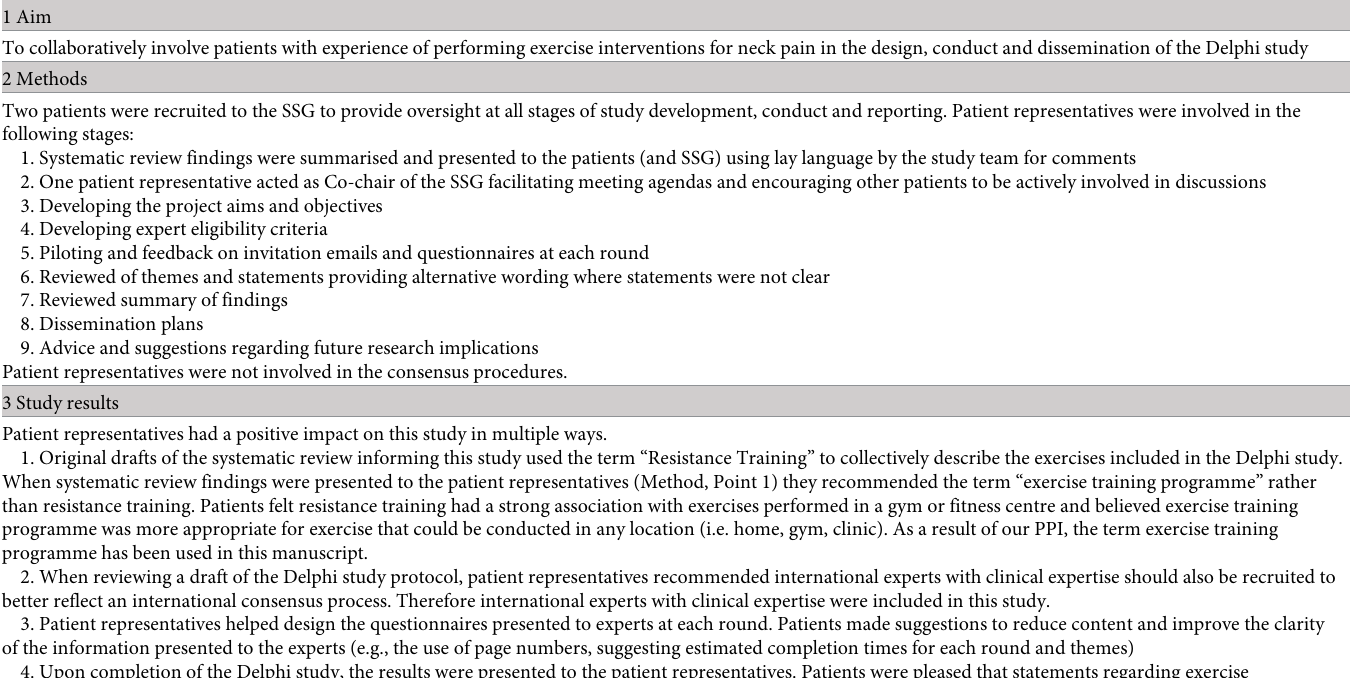
Table 5. GRIPP2 SF reporting patient and public